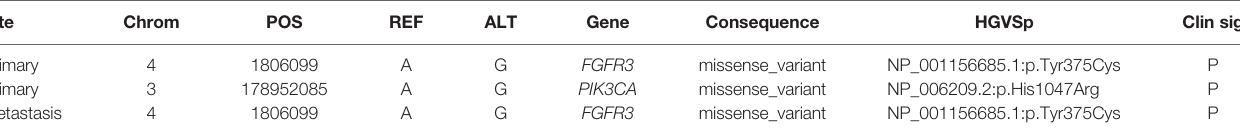
TABLE 1 | Genetic mutations and their possible predictive